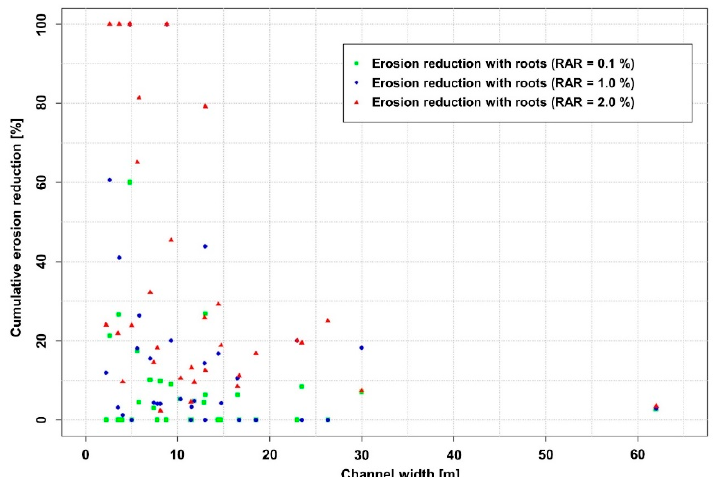
Figure 10. Stabilizing effects of roots on hydraulic bank erosion in relationship to channel width. The points represent the cumulative erosion reduction (%) with RAR = 0.1% (green), RAR = 1% (blue) and RAR = 2% (red).